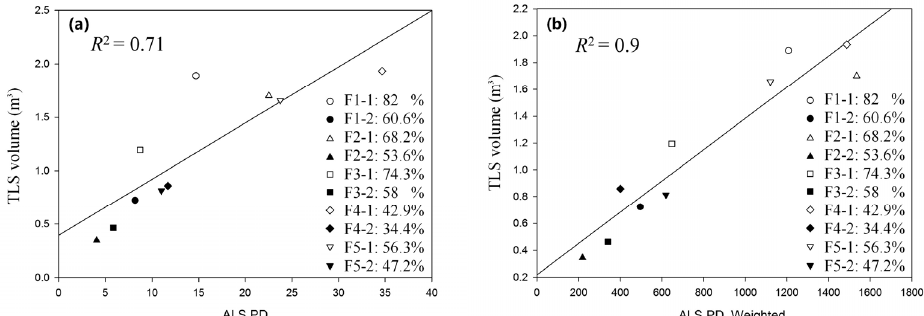
Figure 4. Comparison of PD ( a ), weighted PD ( b ) from Airborne Laser Scanning (ALS) and Terrestrial Laser Scanning (TLS)-derived volume in the understorey. White and black scatter points are the five plots before and after forest tending, respectively. In the legend, all plots are marked by different percentile distribution (PD) values for the ALS return points in the overstorey. Before forest tending, plot F1 had the greatest overstorey canopy cover (82%), as calculated using the percentage of return points in ALS in the overstorey.